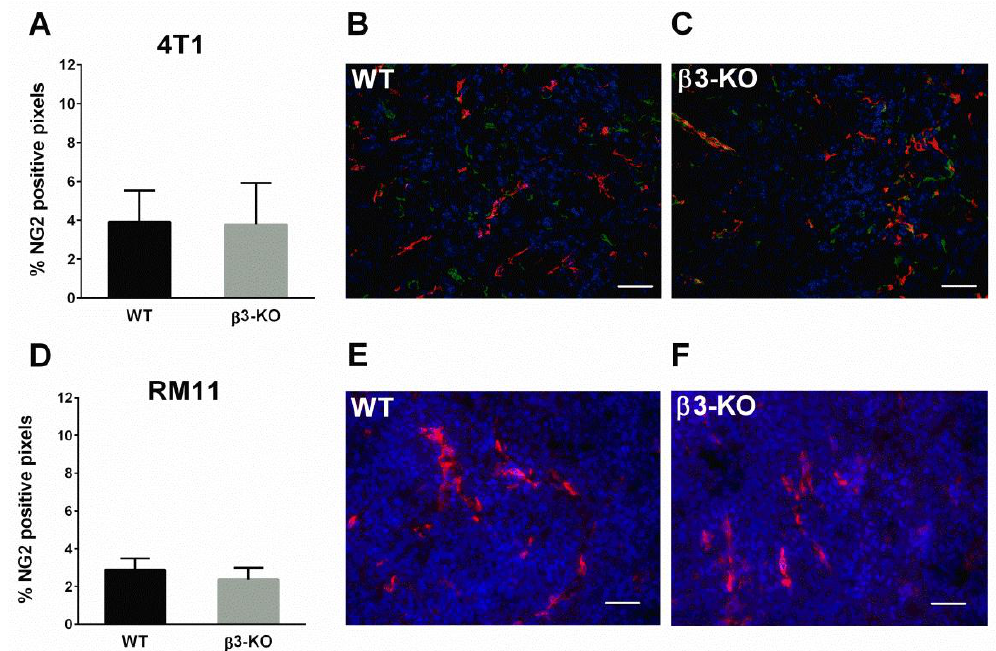
Figure 5. Percentage of pixels positive for NG2 in 4T1 ( n = 5) and RM11 ( n = 4 and n = 6) tumors ( A , D ) from WT and β3-KO mice were calculated using immunofluorescent images. No statistical differences in 4T1 ( p = 0.90) or RM11 ( p = 0.23) were found. Mean ± SD. Representative images of NG2-staining from both genotypes of 4T1 ( B , C ) (NG2 green, CD31 red) and RM11 ( E , F ) (NG2 red) tumors are shown. Scale bars indicate 50 µm.